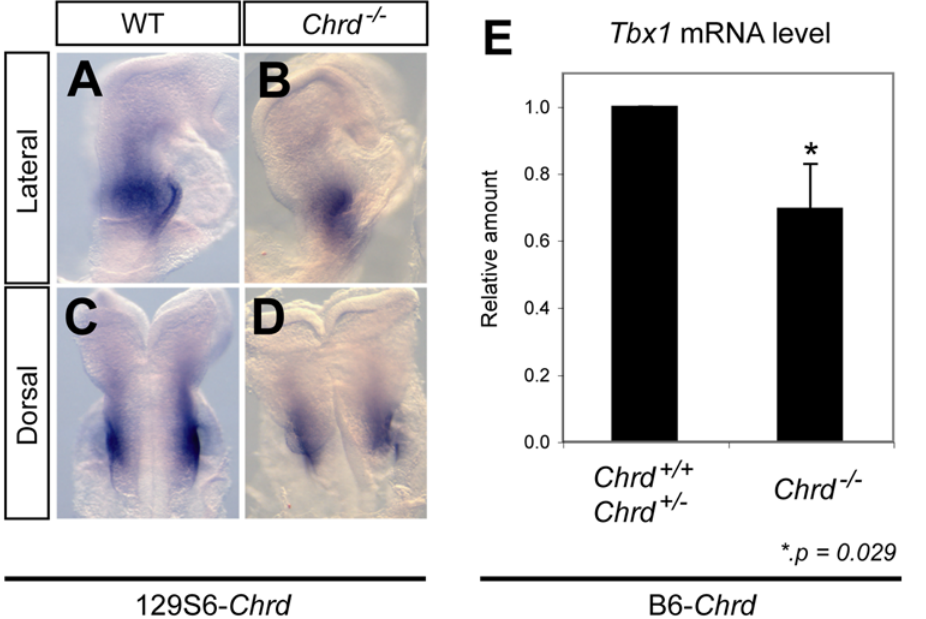
Figure 4. Reduced expression of Tbx1 in 129S6- and B6- Chrd 2 / 2 embryos. In situ hybridization at 5-somite stage of Tbx1 in 129S6- Chrd + / + (A,C) and 129S6- Chrd 2 / 2 embryos (B,D), displaying reduced expression in pharyngeal area of homozygotes with a DGS-like phenotype. (E) Quantitative PCR of Tbx1 mRNA in embryos of the genotypes B6- Chrd + / + and B6- Chrd + / 2 (n=8) versus B6- Chrd 2 / 2 (n=4), demonstrating a modest but significant (p=0.029) reduction of Tbx1 expression despite the absence of a DGS-like phenotype in B6- Chrd 2 / 2